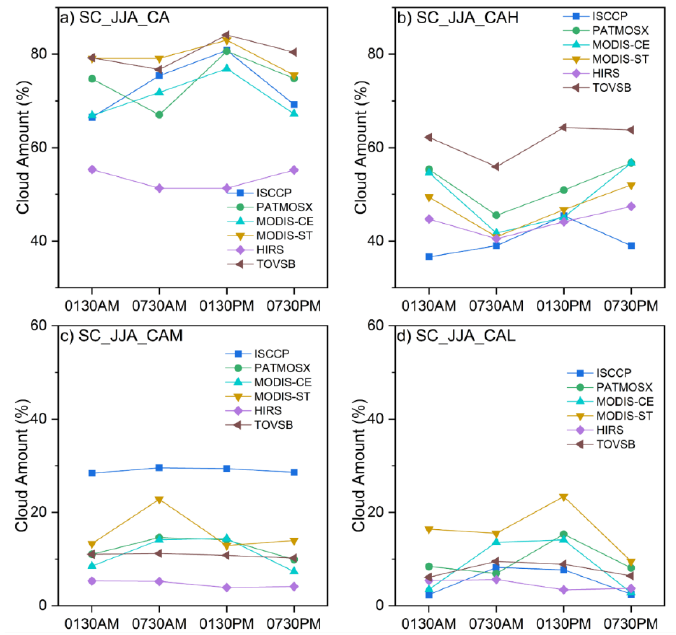
Figure 6. ( a ) Total cloud amount (CA), ( b ) high-level cloud amount (CAH), ( c ) mid-level cloud amount (CAM), and ( d ) low-level cloud amount (CAL) retrieved at four observation times for six satellite datasets in summer over south China, unit: %. The observation times of PATMOSX, MODIS-CE, MODIS-ST, HIRS, and TOVSB are 01:30, 07:30, 13:30, and 19:30 local time, and the observation times of ISCCP are 03:00, 09:00, 15:00, and 21:00 local time.